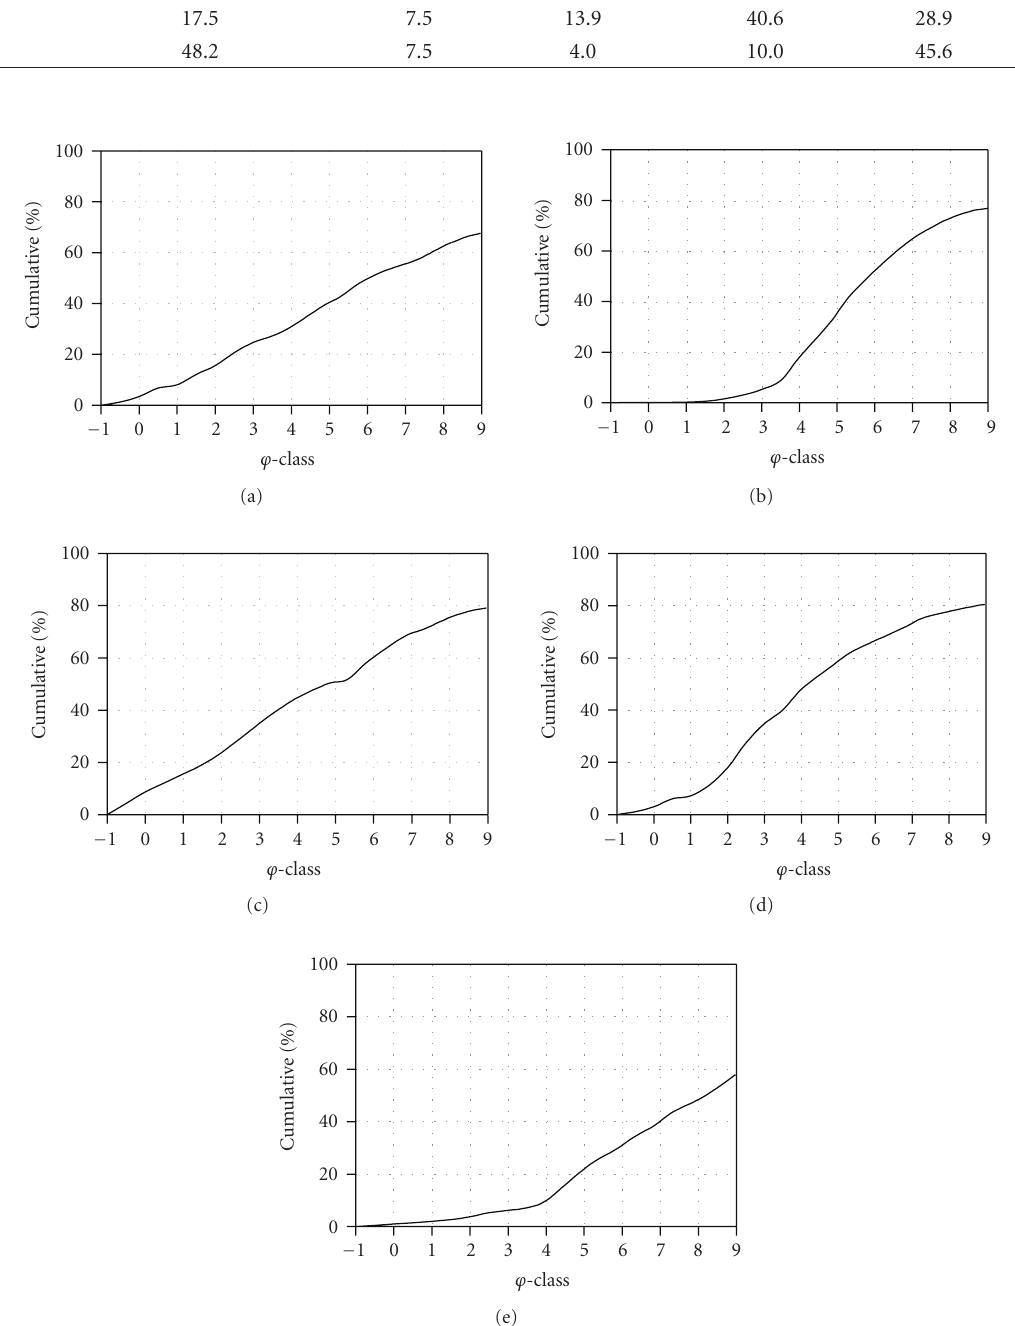
Figure 3: Cumulative frequency curves of soil particles sizes from 5 nesting sites of L. malachurum . On the x -axes there are represented the values expressed as ϕ -units (-log 2 of the diameter of the particles, in mm) and on the y -axes the cumulative percentages of the particles representing the di ff erent granulometric classes. (a)–(e): sites